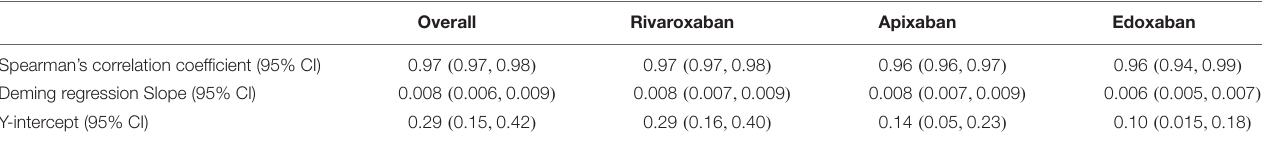
TABLE 2 | Accuracy of universal, heparin-calibrated anti-Xa assay with regard to drug concentration in 845 patients taking rivaroxaban, apixaban, or edoxaban in clinical practice.